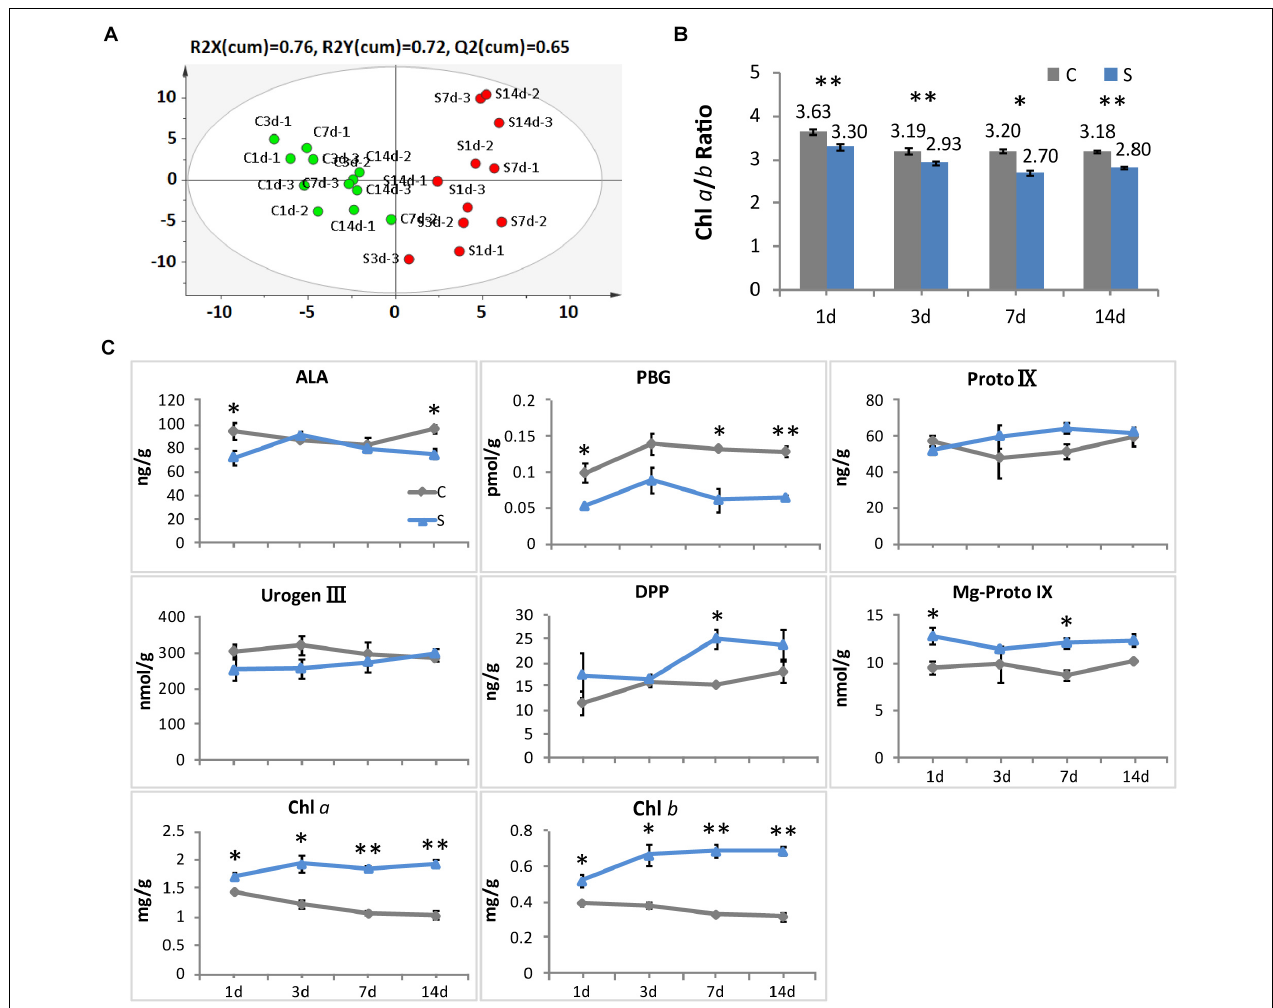
FIGURE 2 | Effect of shade on the concentrations of chlorophylls and the main precursors in tea leaves. (A) The OPLS-DA analysis of the main precursors and chlorophylls in tea leaves from the control and shade treatments. (B) The ratio of chlorophyll a and chlorophyll b in tea leaves from the control and shade treatments. (C) The accumulation of chlorophylls and main precursors in tea leaves from the control and shade treatments. 4h, 1d, 3d, 7d, and 14d indicate time points during the shade period. ALA, 5-aminolevulinic acid; PBG, porphobilinogen; Proto IX, protoporphyrin IX; Urogen III, uroporphyrinogen III; DPP, divinyl protochlorophyllide; Mg-Proto IX, Mg-Protoporphyrin IX; Chl a , chlorophyll a ; Chl b , chlorophyll b . Data shown are from three independent biological replicates ( n = 3). ∗ Significant differences comparing the control treatment at each time point according to one-way ANOVA test and a Fisher’s LSD at the 5% significance level ( ∗ p ≤ 0.05, ∗∗ p ≤ 0.01). OPLS-DA analysis was conducted by SIMCA 13.0 (UMETRICS,